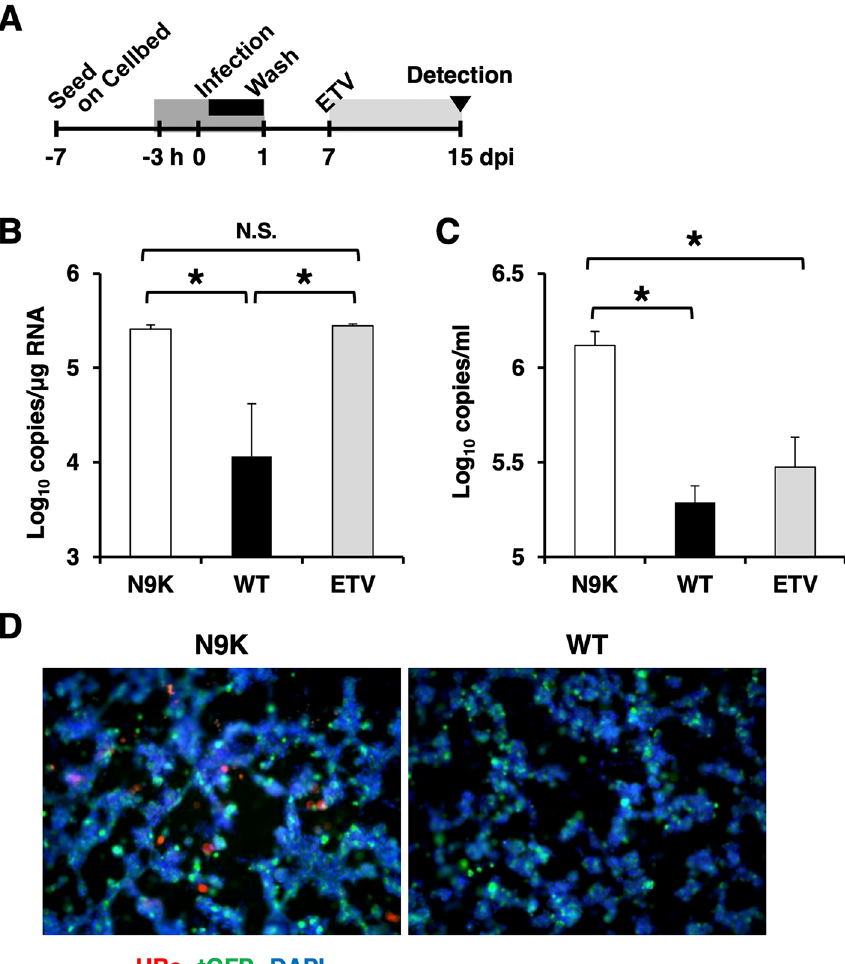
Figure 3. ( A ) Schema of the schedule for HBVbb infection experiment using E/NtG8 cells cultured on Cellbed is shown. Inoculation time of the 3D-cultured cells with HBVbb is shown in the black box. The time of treatment with HBV preS1 peptide is shown in the dark gray box and treatment with ETV is shown in the light gray box. After infection, the cells were cultured for 2 weeks. ( B ) The amount of HBV pgRNA in 3D-cultured E/ NtG8 cells infected with HBVbb (genotype C) was evaluated by qRT-PCR at 15 dpi. ( C ) Culture media of the HBVbb (genotype C)-infected cells were collected every 2 days. The amounts of extracellular HBV DNA in the media were evaluated by qPCR at 15 dpi. ( D ) HBVbb (genotype C)-infected cells were immunostained with anti-HBs antibody. The image contains the overlay of HBs (shown in red), NTCP-tGFP (shown in green) and DAPI-stained nuclei (shown in blue). Levels of significance: * and N. S. indicate “p < 0.05” and “no significant difference”,